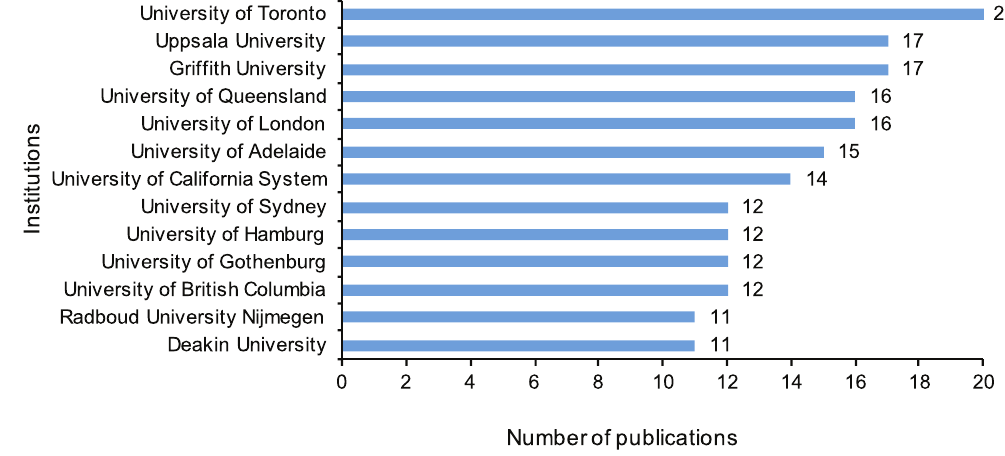
Figure 2: Information of 13 institutions that contributed over 10 citations to Research Frontier